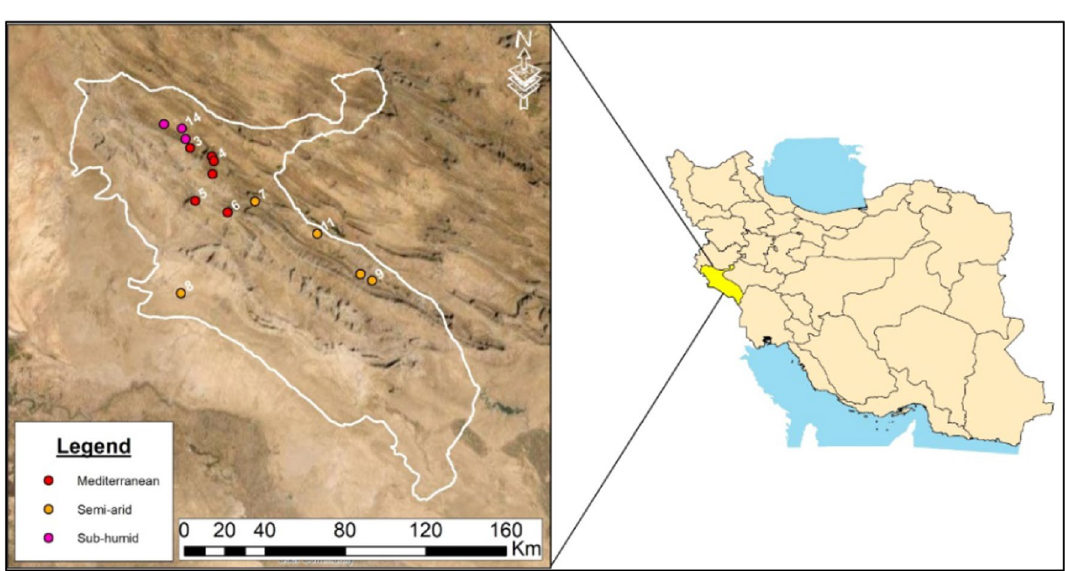
Figure 7. Location of the forests sampled in the Ilam Province in western